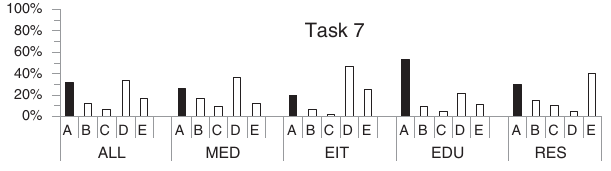
FIG. 2. The students ’ responses to the task referring to the gas volume concept. For a detailed description see Fig.